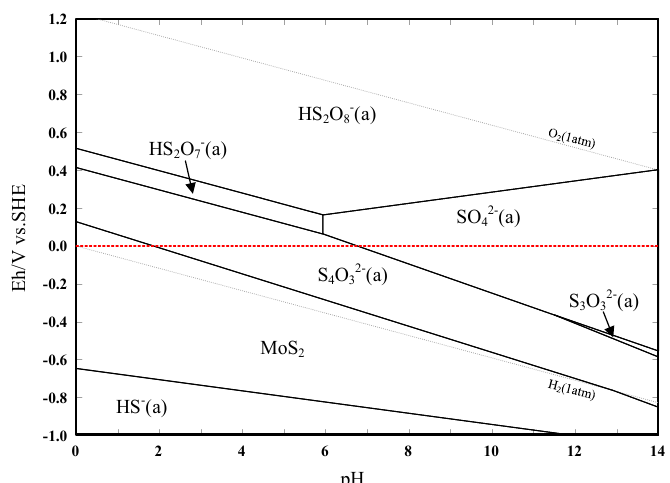
Figure 10. The Eh–pH diagram for the S ‐ Mo ‐ H 2 O system. Conditions: 2 × 10 − 4 M sulfur, 1 × 10 − 4 M molybdenum, 298.15 K, 1 atm.